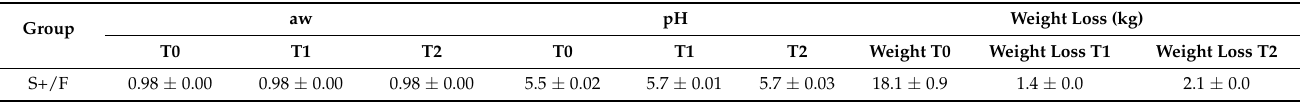
Table 5. Activity water (aw), pH, and weight loss during meat maturation time comes from animals fed with green forage and bred at low density (S+/F) in Longissimus muscle at T0, 30 days (T1), and 60 days (T2) after maturation. Group aw pH Weight Loss (kg) T0 T1 T2 T0